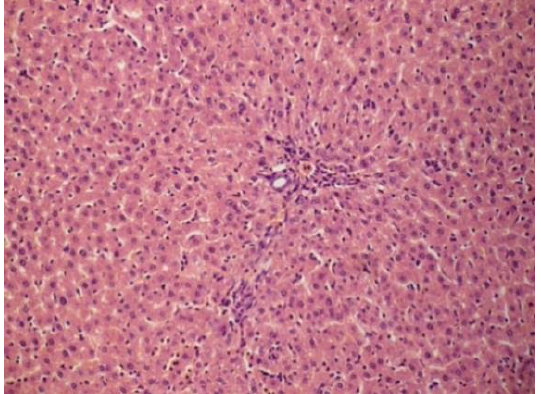
Fig. 11. SHR rat liver. Combined long-term therapy (ramipril and corvitin). Staining with hematoxylin and eosin. Eye. 10×. Lens.